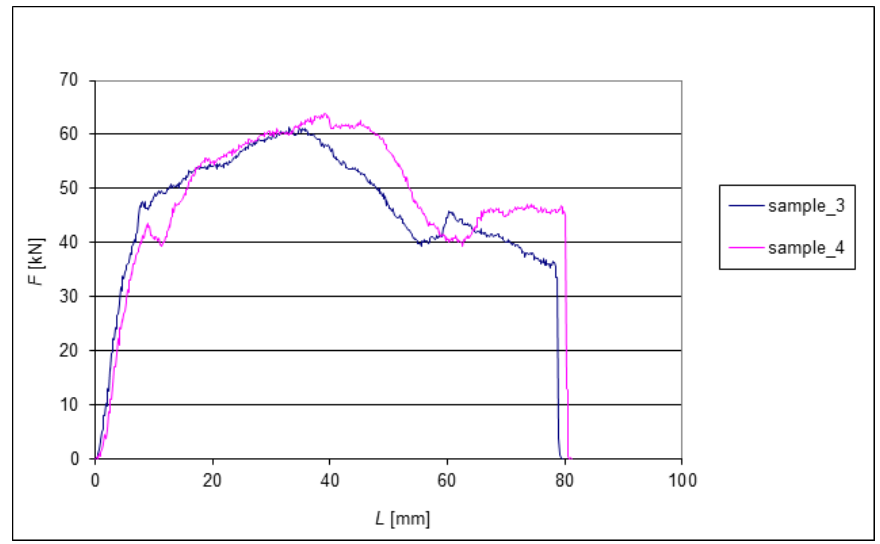
Figure 9. Dependence of the force on the length of extrusion during the fourth pass through the ECAP die.